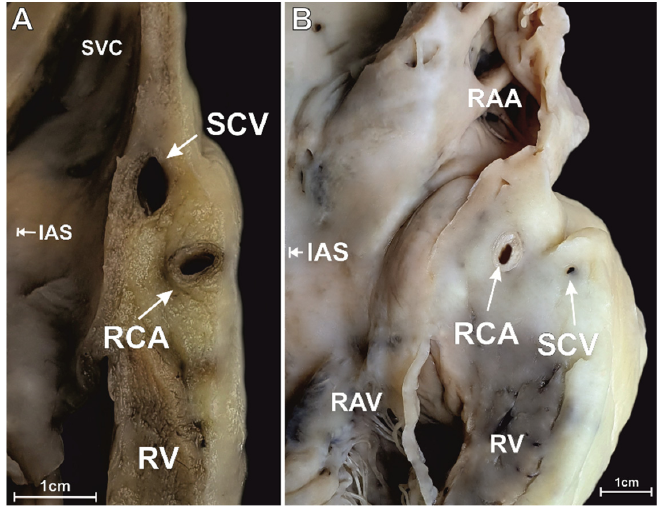
Figure 2. Photographs of a cadaveric heart specimen showing the longitudinal section through the superior right atrial appendage (RAA) isthmus. Cases with two main coronary vessels in different arrangements are presented. ( A ) vein closer to the endocardium than the artery but closer to the RAV. ( B ) artery closer to the endocardium than the vein and in the same sector. IAS—interatrial septum, RAV—right atrio-ventricular valve, RCA—right coronary artery, RV—right ventricle, SCV—small cardiac vein, SVC—superior vena